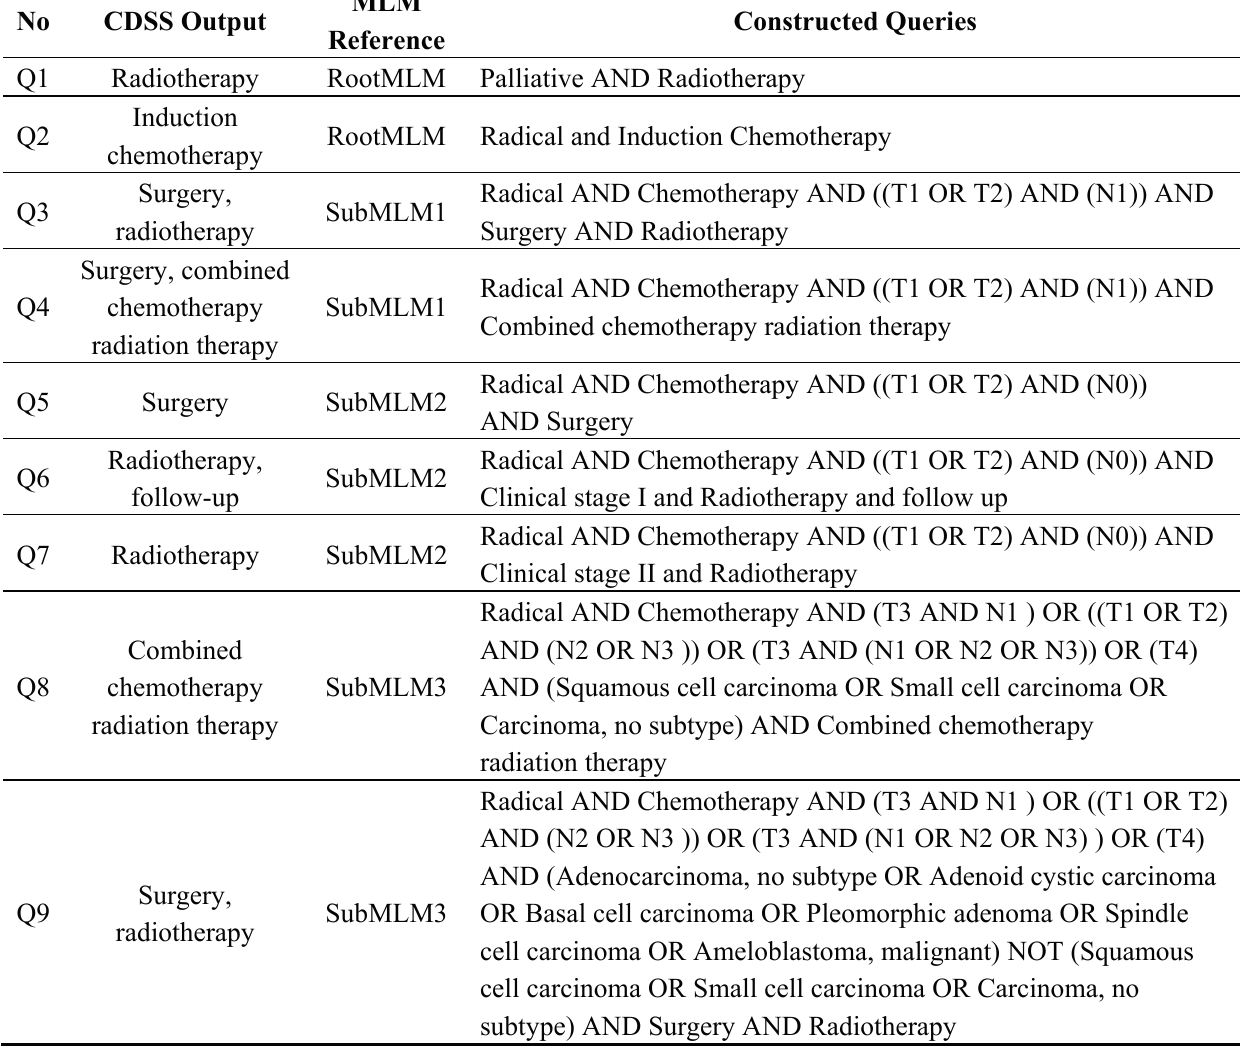
Table 3. Contents of queries constructed from the executed paths in KB of CDSS